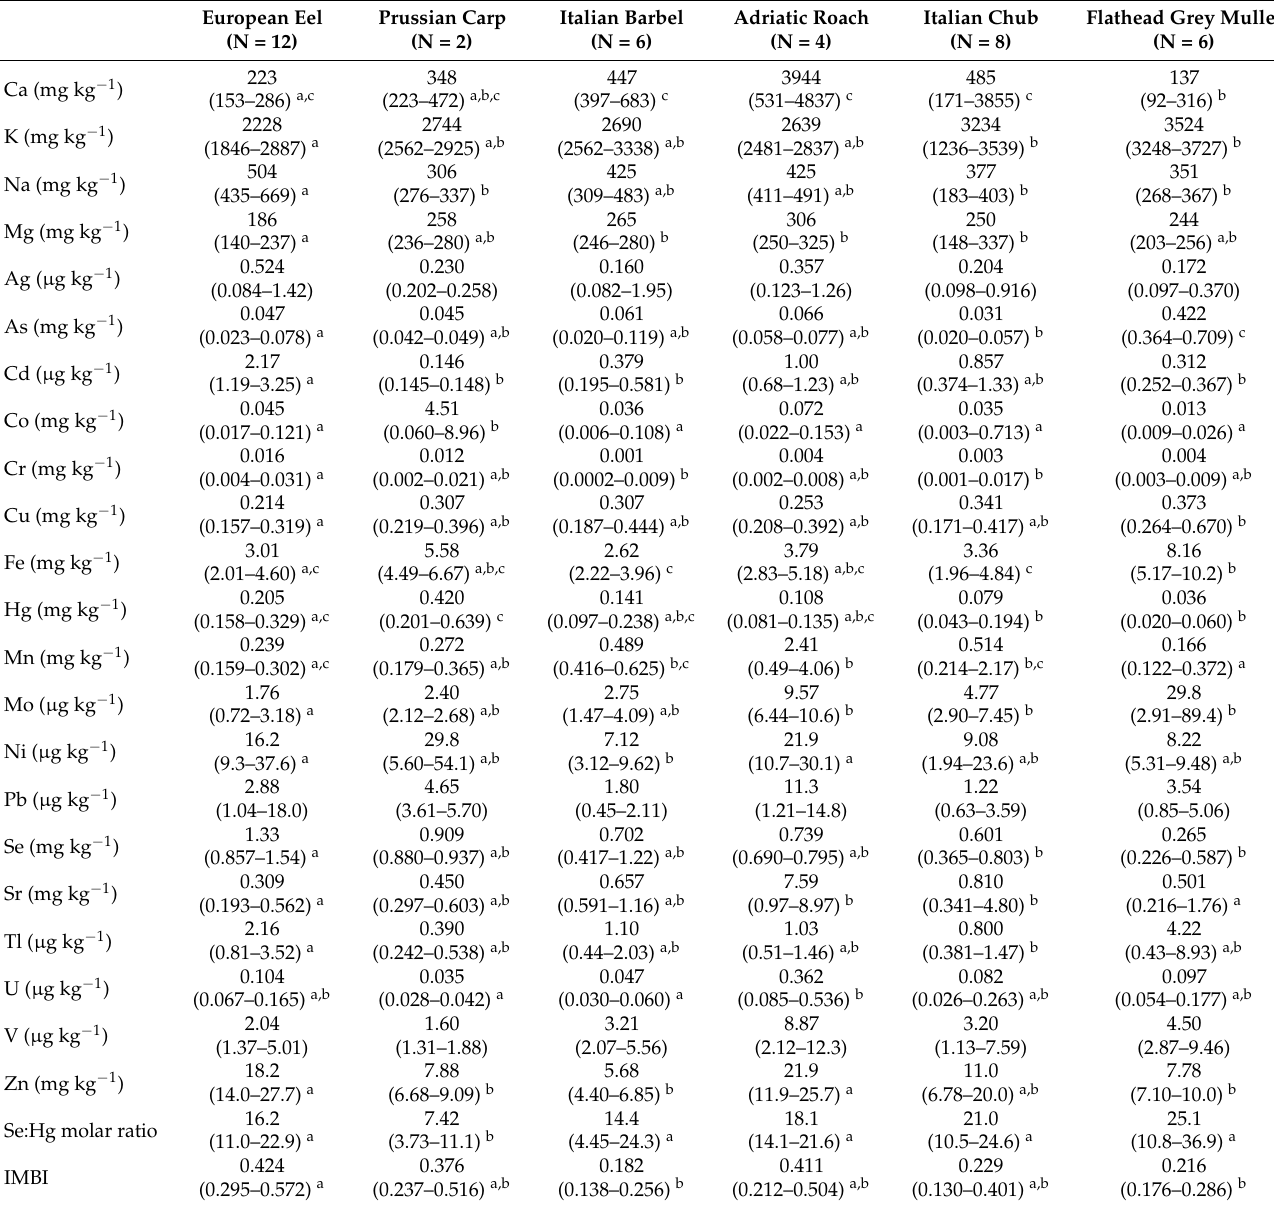
Table 4. Macro and trace element concentrations (in mg kg − 1 or µ g kg − 1 wet weight) and median (range) Se:Hg molar ratios and IMBI values in the muscle tissue of six fish species from the Raša River, Istria,